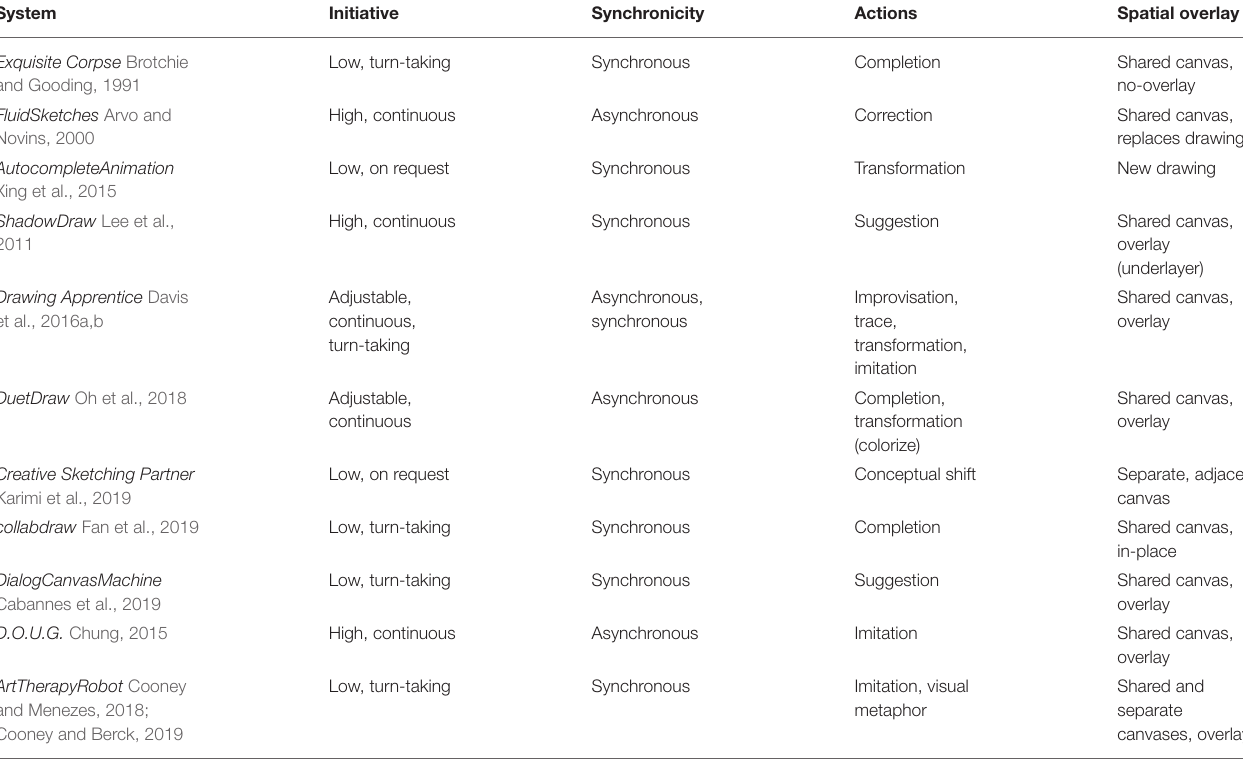
TABLE 6 | Co-creative drawing systems characterized by interaction factors (section 7.1) and actions (section